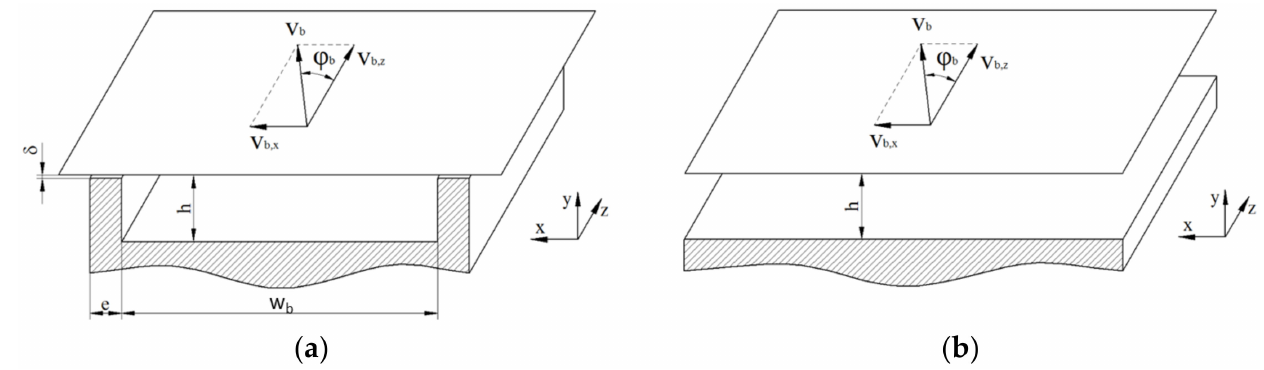
Figure 4. Flat-plate model of the helical screw channel ( a ). For shallow screw channels with h / w b < 0.1, the effect of the screw flights can be ignored ( b